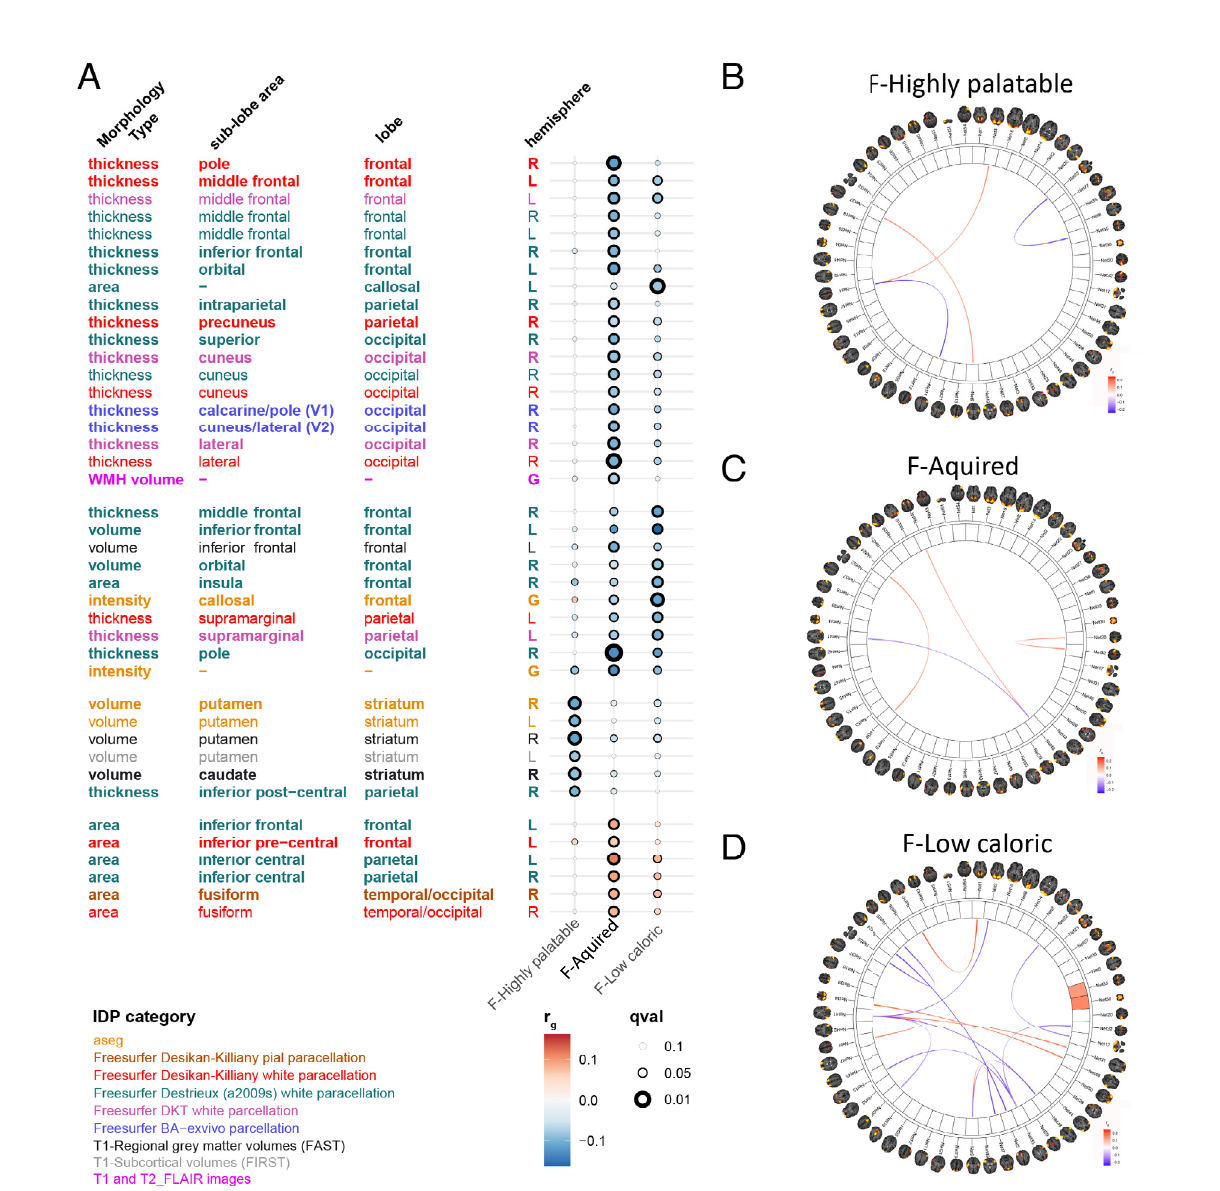
Fig. 4 Genetic correlations between three main food-liking dimensions and brain MRI traits. Only traits with q-value < 0.05 have been reported. Panel A reports the genetic correlations between the three main liking dimensions and brain MRI morphological traits. Colour re fl ects the atlas used while size of the dots size is proportional to q-values. Panels B – D genetic correlations with the ICA100 network